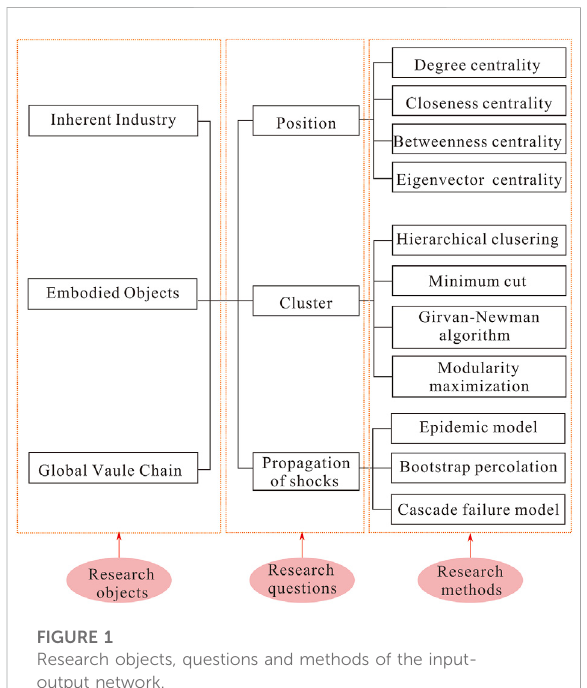
FIGURE 1 Research objects, questions and methods of the input- output